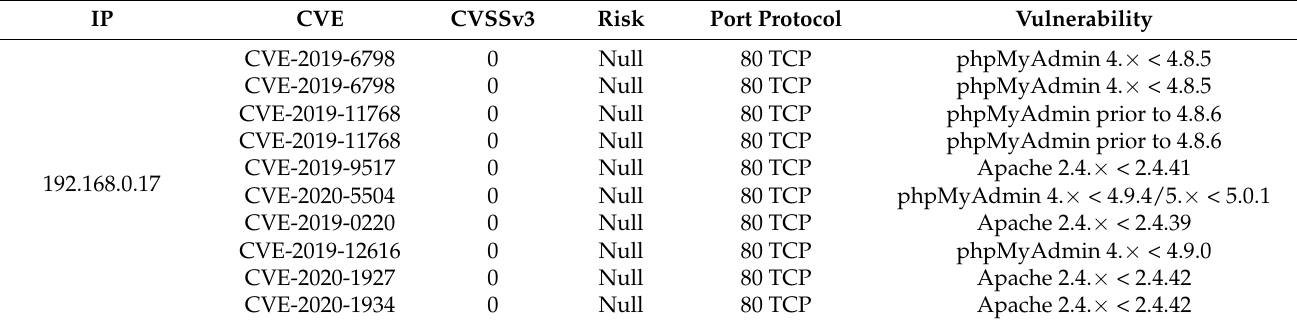
Table 24. Vulnerabilities founded post-hardening.